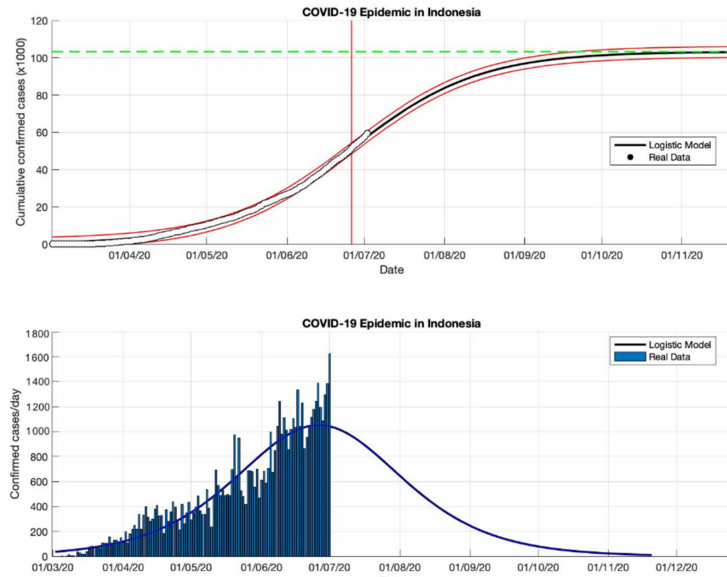
Figure 17. In the above figure, the prediction results of the logistic growth model for cumulative infected cases are compared with the actual data, while the two red lines between the black lines represent a prediction error limit of about 5%. The dashed green line predicts the total size of infected cases in the final phase of the epidemic. The red line intersects the cumulative case curve to predict the turning point or peak point of the epidemic (this line is parallel to the top of the curve from the below figure). In the below figure, the prediction results of this model for daily infected cases in